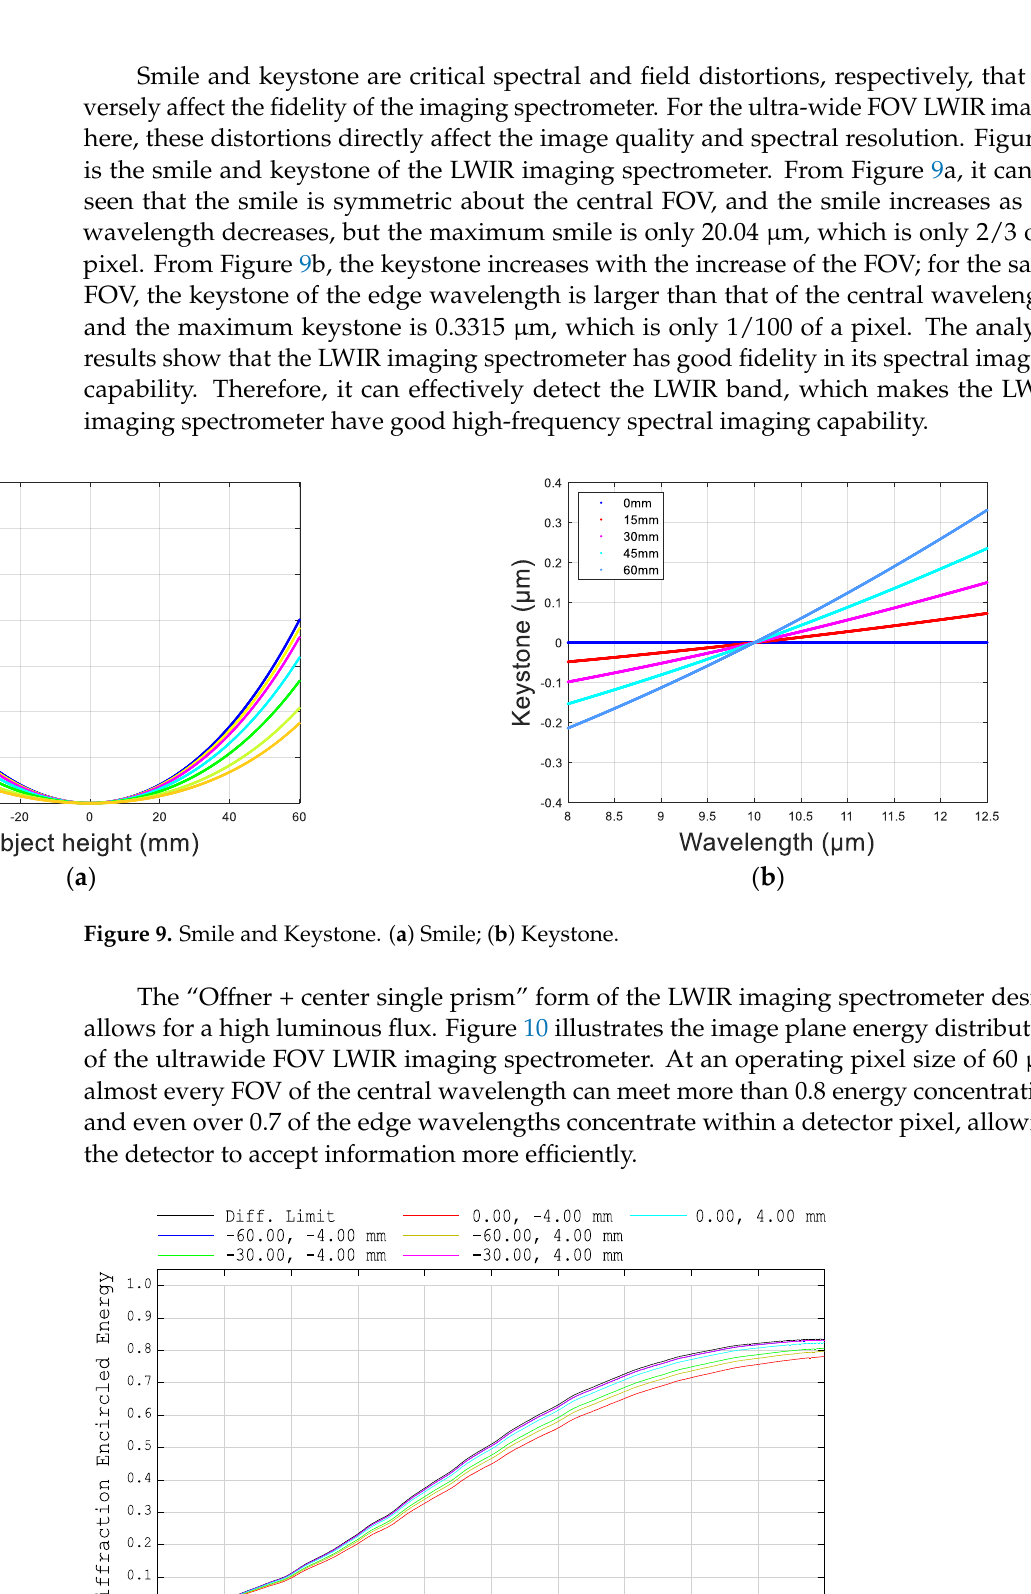
Figure 8. MTF curves for the fields (( − 60 mm, − 4 mm), ( − 30 mm, − 4 mm), (0 mm, − 4 mm), ( − 60 mm, 4 mm), ( − 30 mm, 4 mm), and (0 mm, 4 mm)) along the slit for the central wavelength of 10 μm .